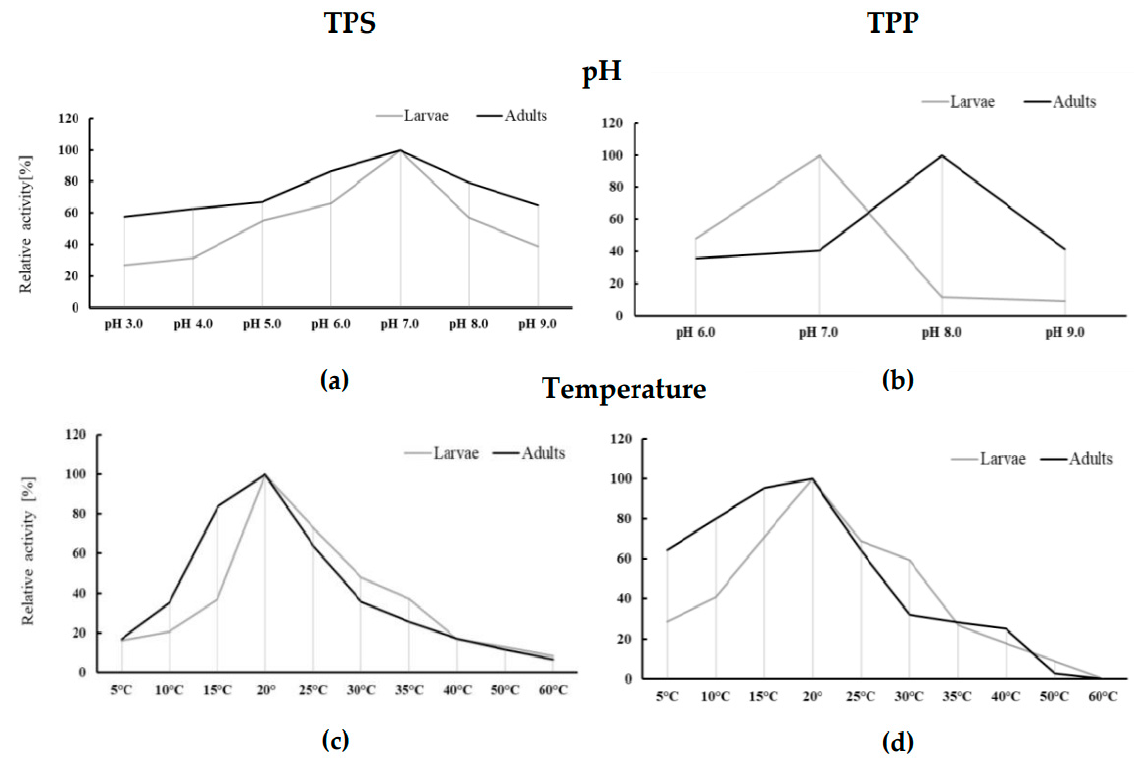
Figure 4. Dependence of activity of trehalose-6-phosphate synthase (TPS) and treha-lose-6-phosphate phosphatase (TPP) from larval and adult Cystidicola farionis on pH ( a , b ) and temperature ( c , d ); ( a ) The maximum activities of TPS at pH 7.0 for larvae (712.75 ± 210.86 U/mg) and adults (329.74 ± 60.40 U/mg] were taken as 100%; ( b ) The maximum activities of TPP at pH 7.0 for larvae (1033.20 ± 84.18 U/mg) and pH 8.0 for adults (859.78 ± 113.87 U/mg) were taken as 100%; ( c ) The maximum activities of TPS at temperature 20 °C for larvae (2320.62 ± 347.97 U/mg) and for adults (666.08 ± 80.50 U/mg) were taken as 100%; ( d ) The maximum activities of TPP at temperature 20 °C for larvae (1337.82 ± 101.31 U/mg) and for adults (860.43 ± 69.78 U/mg) were taken as 100%; ( a – d ) Mean ± SD; n = 9.